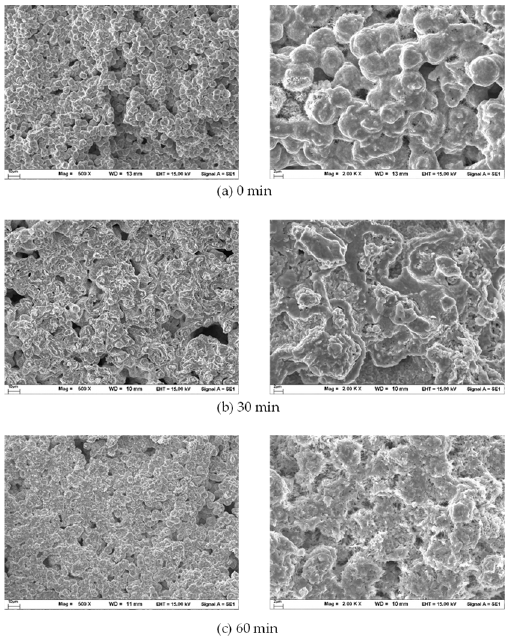
Figure 9. SEM images of sintered nano-copper clay with different heating times at ( a ) 0 min, ( b ) 30 min, and ( c ) 60 min.